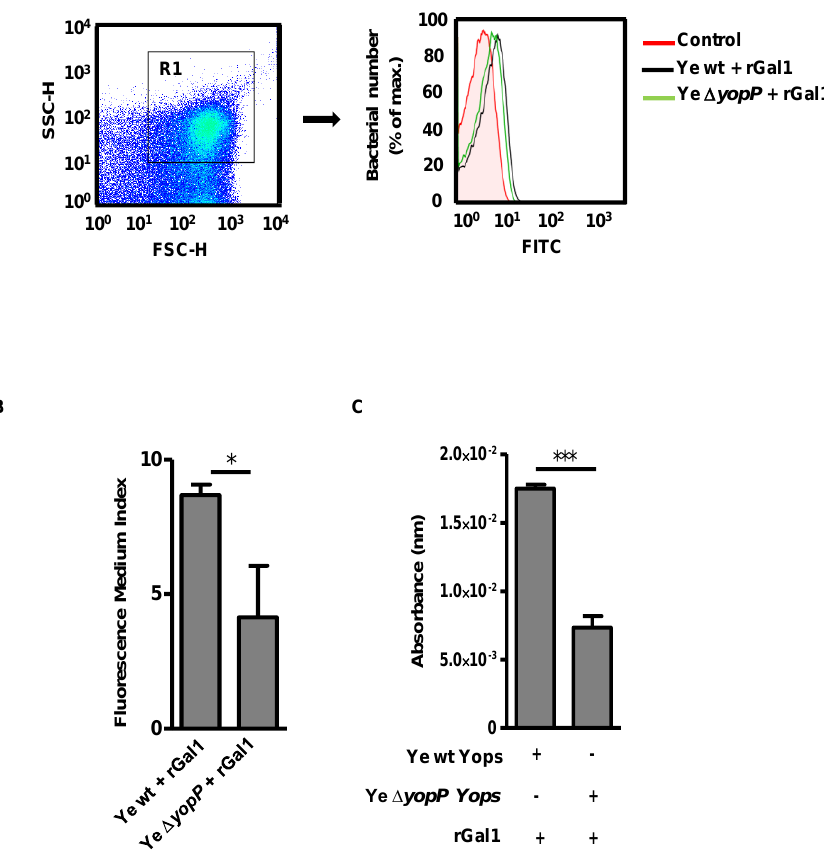
Figure 1. Galectin-1 Binds to Ye YopP.Binding of rGal1 to Ye wt (black) or to Ye ∆ yopP (green) is shown. Control (Ye without rGal1) is shown in red. Binding was analyzed by flow cytometry usinga FITC-conjugated anti-Gal1 antibody ( A ). Representative flow cytometry analysis of two independent experiments, showing the gate in Region 1 (R1) and the histogram expressing the number of FITC-positive bacteria. ( B ) Binding is expressed as the Fluorescence Medium Index. ( C ) ELISA plates were coated with Yops from Ye wt or Ye ∆ yopP (10 µg/well) obtained under the same conditions and incubated with 10 mg/mL of rGal1. Gal1 binding was detected using an anti-Gal1 rabbit polyclonal antibody (1/1000). Data are the mean ± SEM of three independent experiments ( B , C ). * p < 0.05, *** p < 0.001.